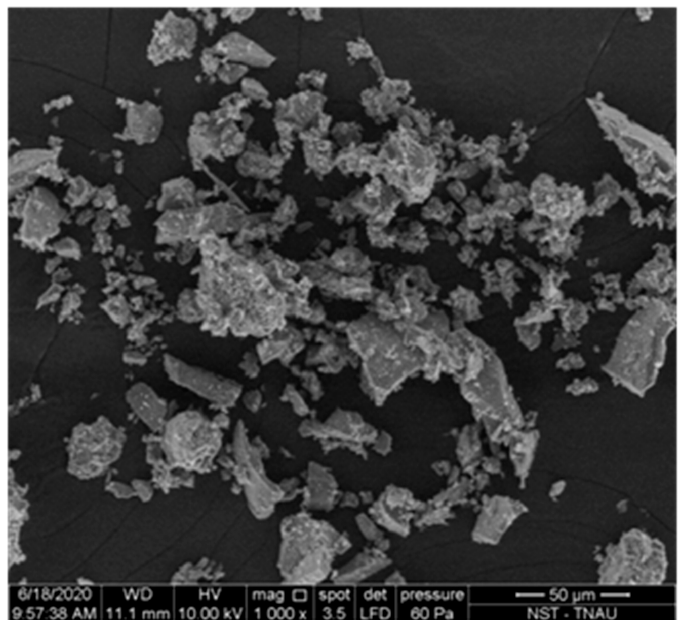
Figure 1. Method of eggshell powder manufacturing.